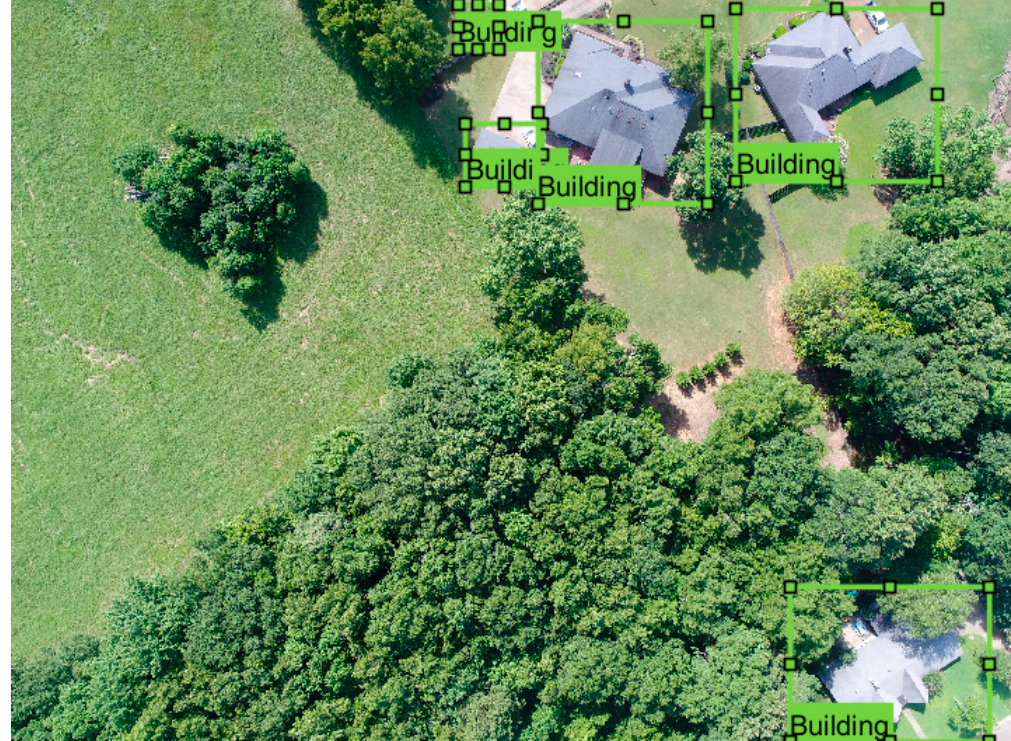
Figure 9. Example box-labeling of real-world data. Of the 119 real images, 37 had at least one building, while the remainder did not have buildings. Of those images with buildings, 16 had exactly one building, while the other 21 had 2–8